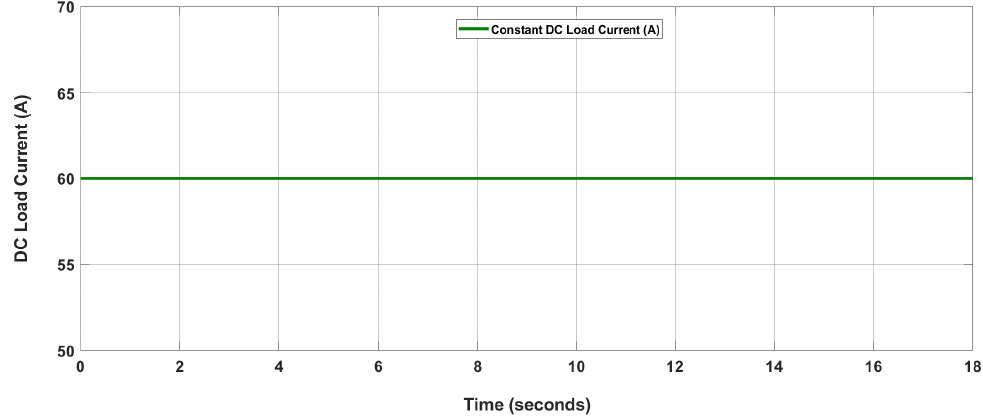
Figure 8. Constant Load Current